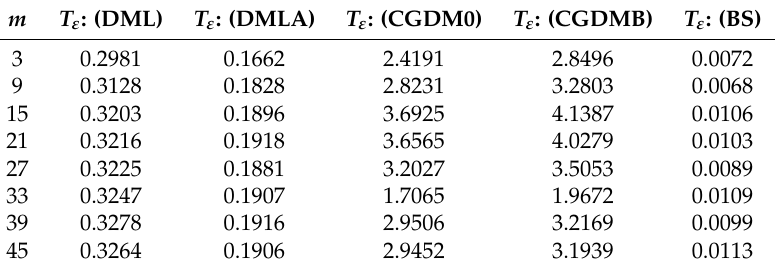
Table 15. Results for Case E with J = 510, ε = 10 − 2 .